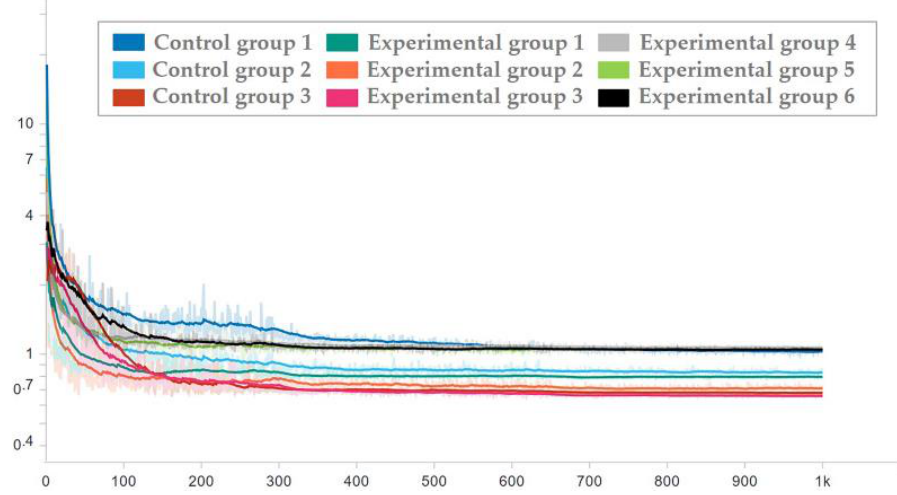
Remote Sens. 2021 , 13 , x FOR PEER REVIEW Figure 17. Loss trend of the test set with random seed 1. Figure 17. Loss trend of the test set with random seed 1.